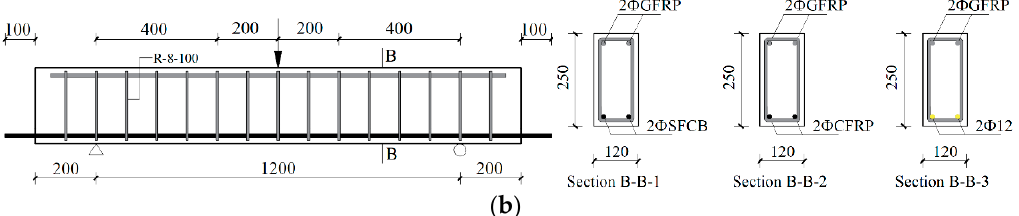
Figure 2. Experimental reinforced concrete (RC) beams (unit is mm): ( a ) Hybrid-reinforced, ( b ) single-reinforced.